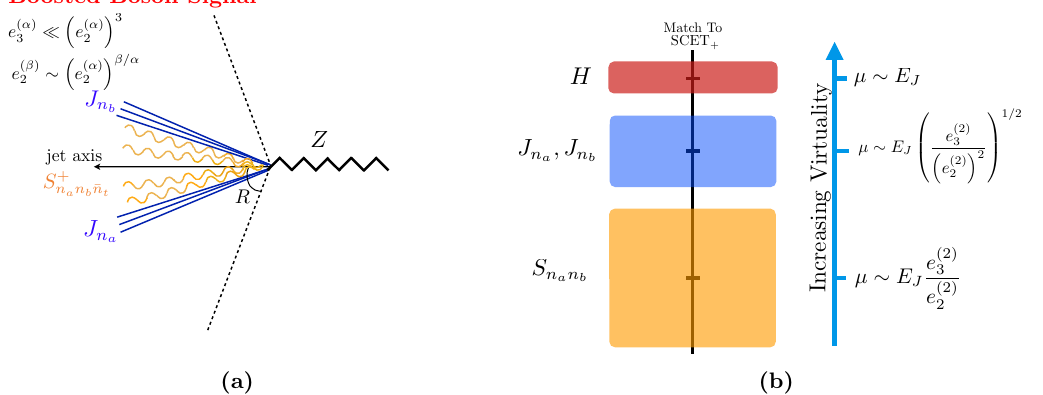
Figure 11. The collinear subjets con(cid:12)guration for a boosted color singlet decay is shown in (a). The structure of factorization formula is shown in (b). Figure from